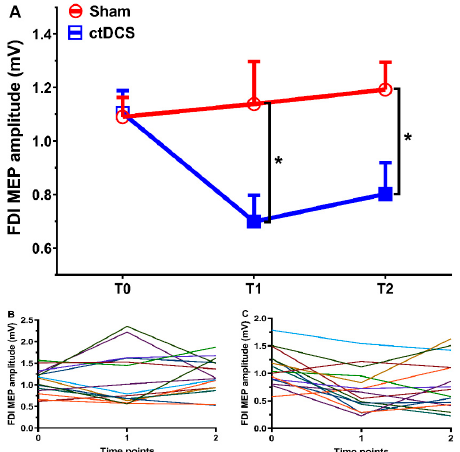
Figure 2. Results of the study. For time points T0, T1, and T2, averaged MEP amplitudes of the first dorsal interosseus (FDI) muscle for all participants ( A ) and individual MEP amplitude in the sham ( B ) and cathodal transcranial direct current stimulation (ctDCS) ( C ) groups are depicted. Filled symbols indicate significant differences of MEP amplitudes after movement observation and execution in comparison to baseline values. Error bars represent standard error of means. *denotes significant differences between groups at p < 0.05.